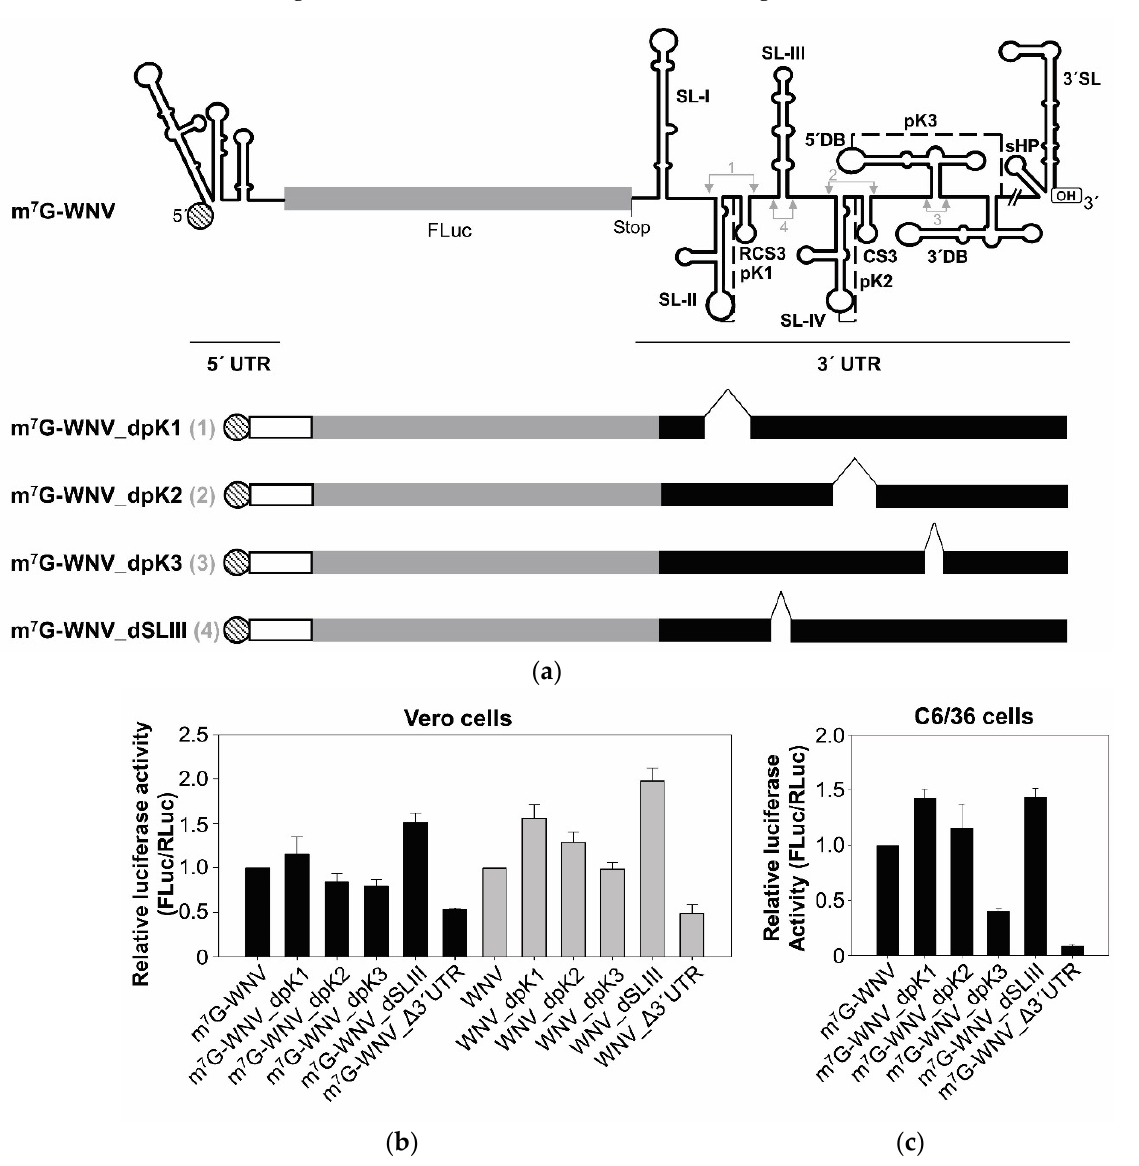
Figure 6. Highly conserved structural elements of the WNV 3 (cid:48) UTR contribute to the regulation of 5 (cid:48) end translation initiation. ( a ) Secondary structure of the WNV subgenomic RNA construct; the secondary structure elements of the 5 (cid:48) and 3 (cid:48) ends of the WNV genome are represented. Arrows indicate the first and last nucleotide included in the deletions to generate the 3 (cid:48) UTR variants dPK1, dPK2, dPK3 and dSL-III (1–4, respectively). A diagram of the deletion RNA construct variants is shown in the lower panel. The key for the different bars is as in Figure 1. ( b ) The translation activity of different capped and uncapped RNA constructs carrying variants of the WNV 3 (cid:48) UTR was determined in Vero cells. Cells were cotransfected with each individual 3 (cid:48) UTR variant RNA construct and m 7 G-RLuc RNA. Translation activity was determined as described in Figure 1. Values refer to that of the corresponding wild type 3 (cid:48) UTR construct. ( c ) The translation activity of different capped RNA constructs carrying variants of the WNV 3 (cid:48) UTR was determined in C6/36 cells. Mosquito cells were cotransfected as in ( b ) and translation activity determined as described in Figure 1. Values are the mean of three independent experiments ± standard deviation. Black and grey bars correspond to the values of the capped and uncapped RNA constructs,